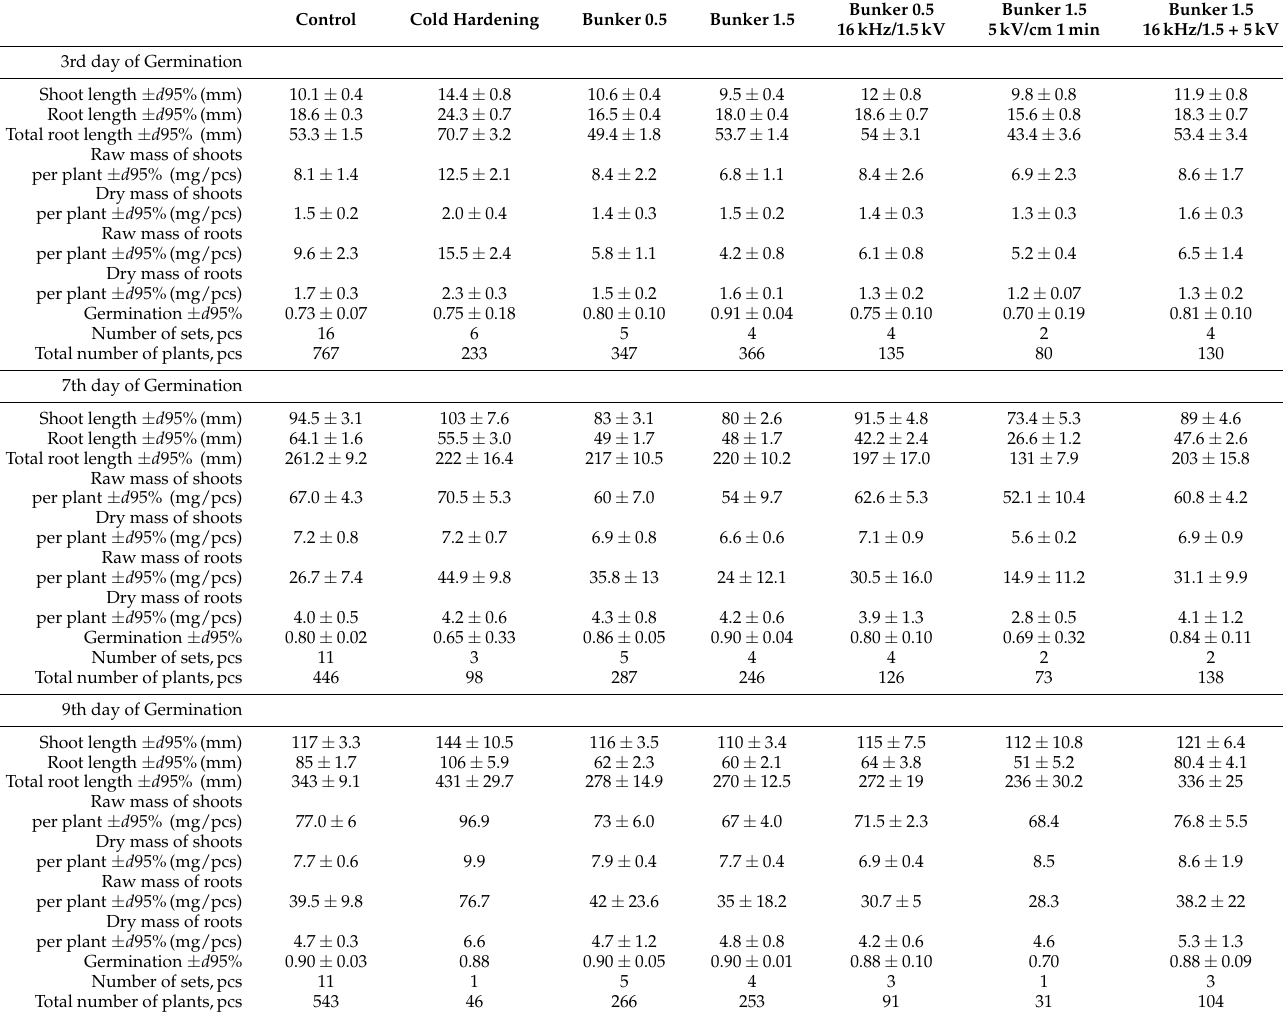
Table 1. Morphophysiological characteristics of seedlings on the 3rd, 7th, and 9th days of devel- opment after seed treatment with cold hardening, disinfectant, plasma, and electric field. Control denotes variants without any treatment; cold hardening refers to cold hardening of the seeds with two stages; Bunker 0.5 indicates samples treated with the “Bunker” disinfectant at a dose of 0.5 L/t and Bunker 1.5 with 1.5 L/t; Bunker 0.5, 16kHz/1.5kV indicates variants with seeds pretreated with “Bunker” disinfectant at a dose of 0.5 L/t and subsequently treated by discharge at 1.5 kV and 16 kHz for 1 min; Bunker 1.5, 5kV/cm 1min denotes variants with seeds pretreated with “Bunker” disinfectant at a dose of 1.5 L/t and subsequently treated with electric field of 5 kV/cm for 1 min; and Bunker 1.5, 16kHz/1.5kV +5kV denotes variants with seeds pretreated with “Bunker” disinfectant at a dose of 1.5 L/t and subsequently treated by discharge at 1.5 kV and 16 kHz with bias voltage of 5 kV for 1